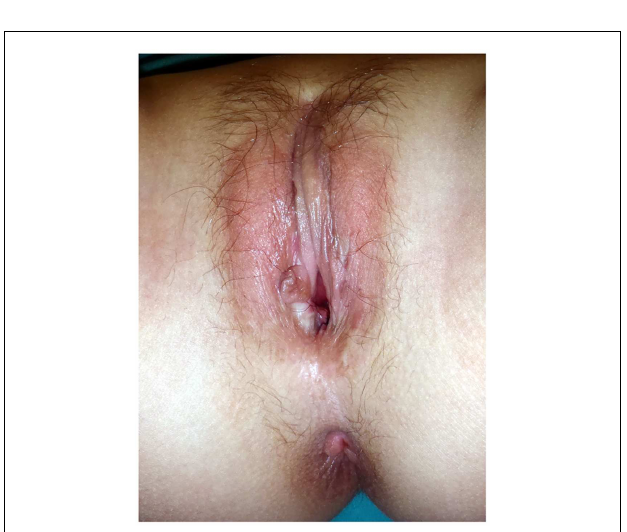
FIGURE 3 |Appearance of the vulva 6years afterTUM with posterior Ω flap .The patient was virilized (Prader 4) because of maternal exposure to